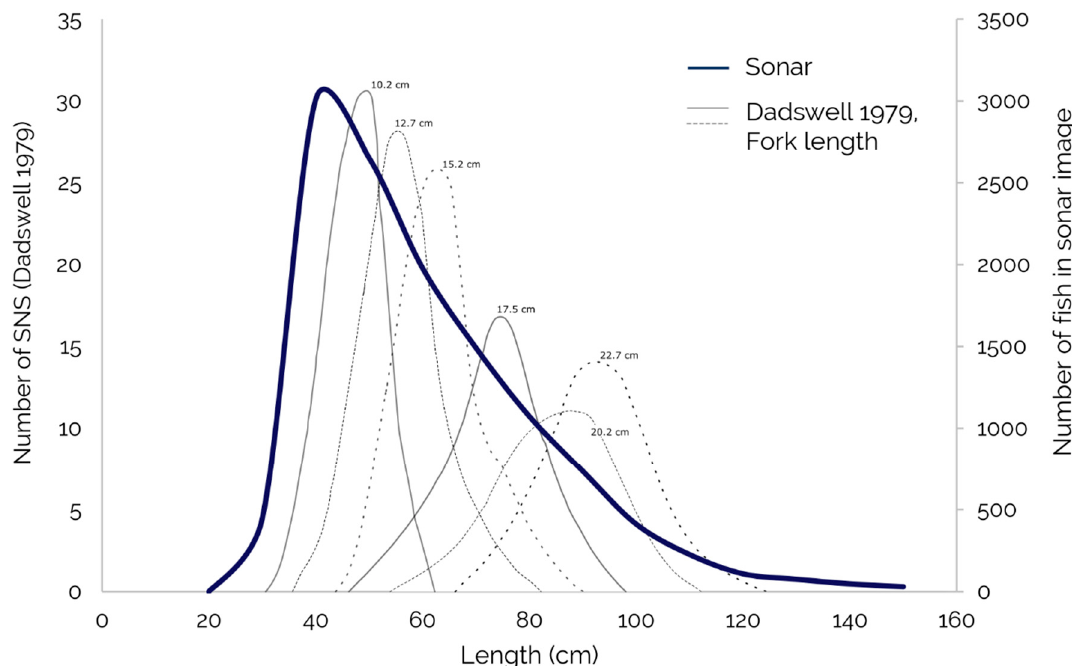
Figure 7. Frequency distribution for Shortnose Sturgeon (SNS) fork length (cm) as per Dadswell 1979 [8], superimposed with the frequency distribution of fish lengths obtained via the sonar image, and a supervised maximum likelihood classification (sMLC), where number of SNS from Dadswell’s study are displayed on the left y -axis, and number of fish derived via sonar and sMLC are displayed on the right y -axis, and the numbers above the solid and dashed lines for the Dadswell curves represent the employed gillnet mesh size (cm) in the SJR. Pixel resolution for sonar derived frequency distribution curve was 7.5 cm.